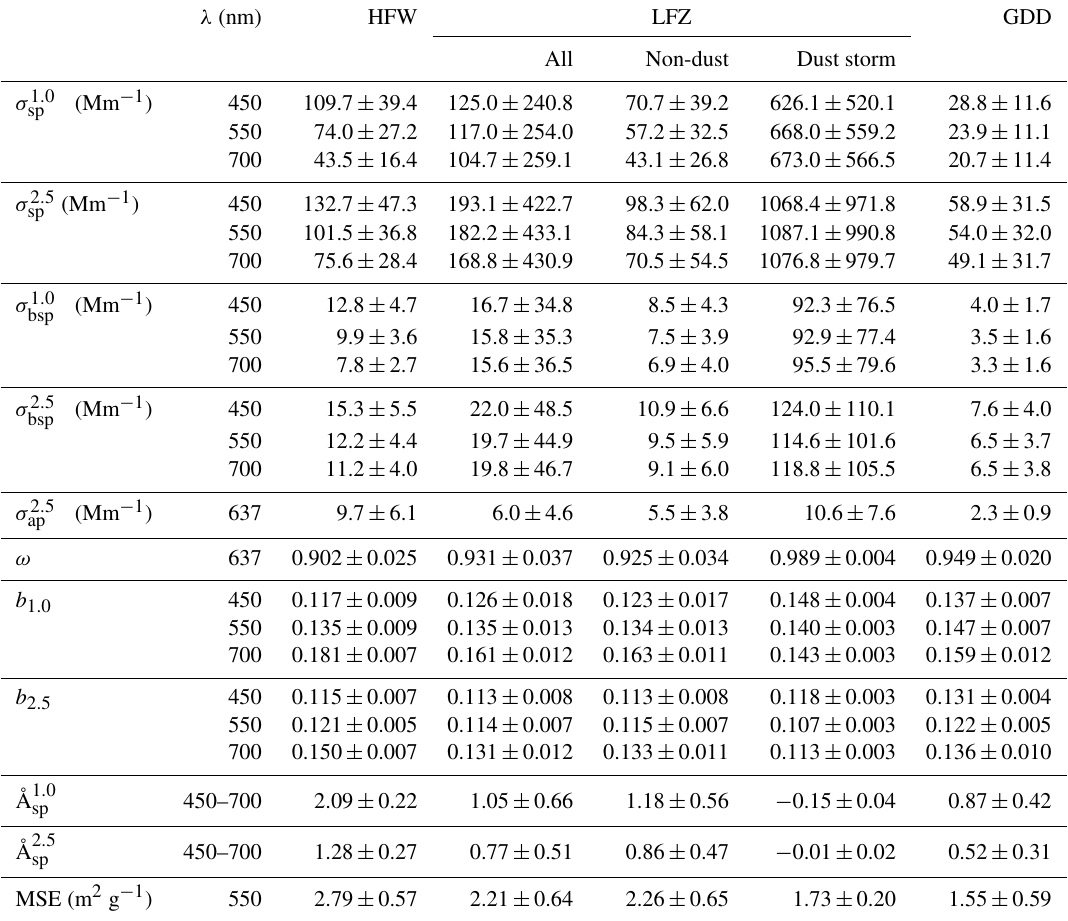
Table 2. Statistics of optical properties of aerosols measured at the three sites from 3 April to 16 May 2014. Results are given as the mean ± the standard deviation, which was based on hourly averaged